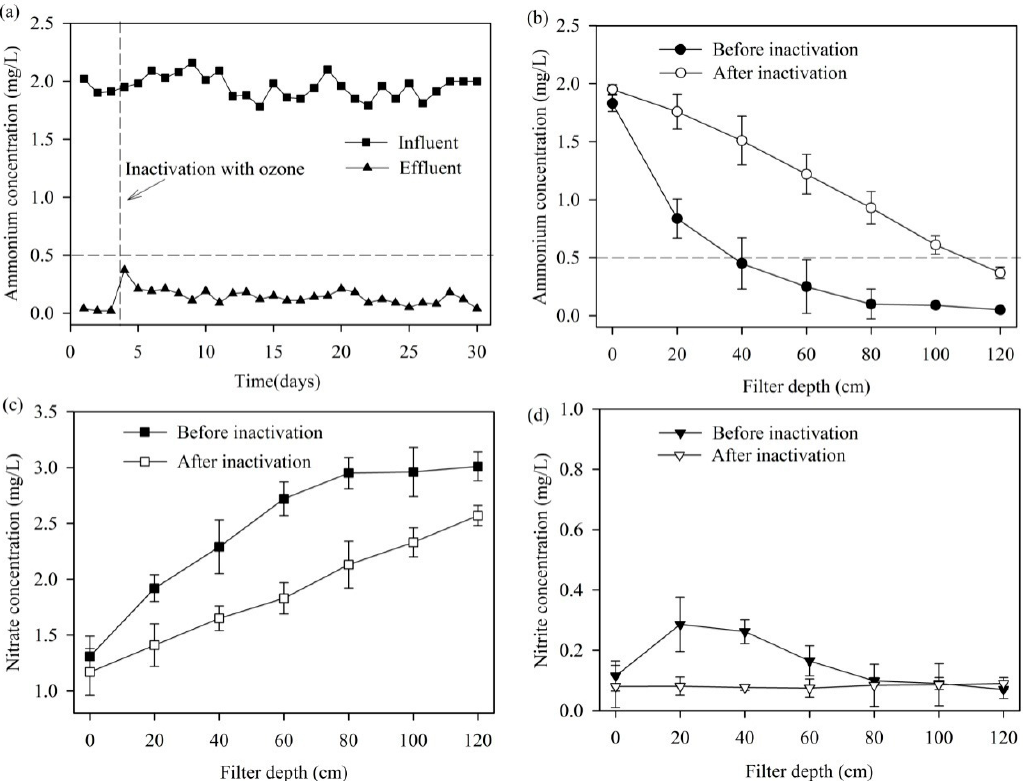
Figure 6. Ammonium removal performances of the MeOx filter before and after inactivation: ( a ) influent and effluent ammonium concentrations, ( b ) ammonium, ( c ) nitrate and ( d ) nitrite concentration depth profiles.